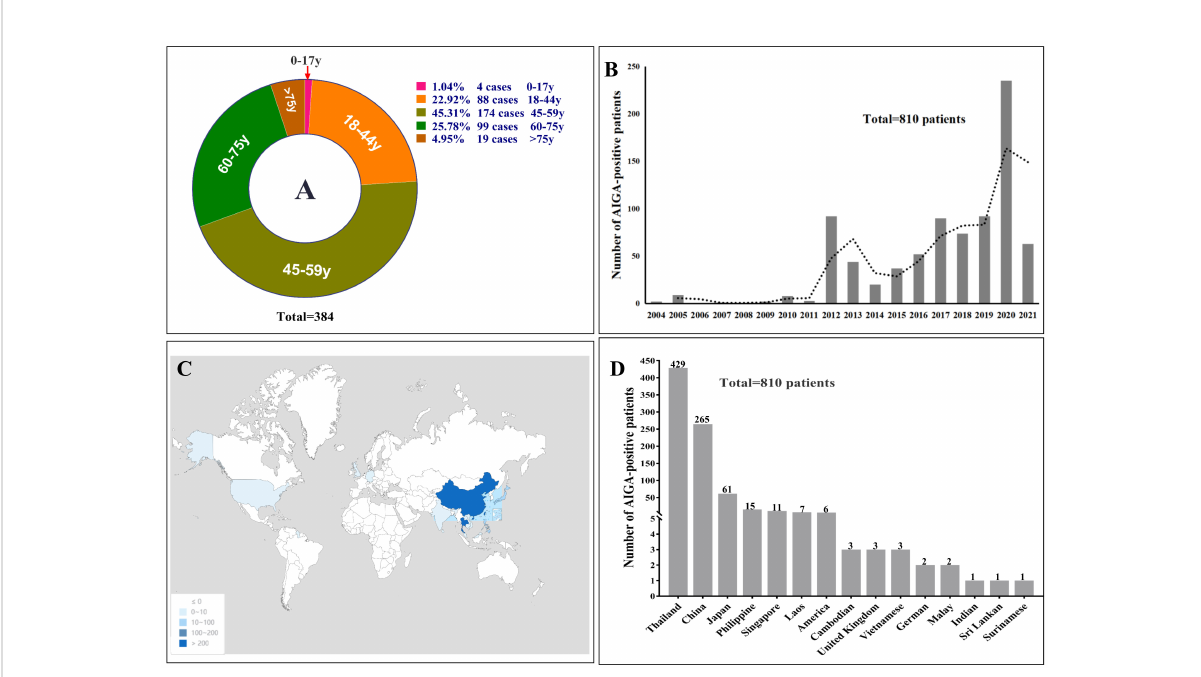
FIGURE 2 (A) The percentage of different age stages with AIGA-associated immunode fi ciency. The reason for the statistical number of age, which was 384, was that most clinical cohort studies did not mention the age of each patient; therefore, the age data of the rest patients were missing in the systematic literature review. (B) annual incidence trends of AIGA. (C, D) geographical characteristics of the study